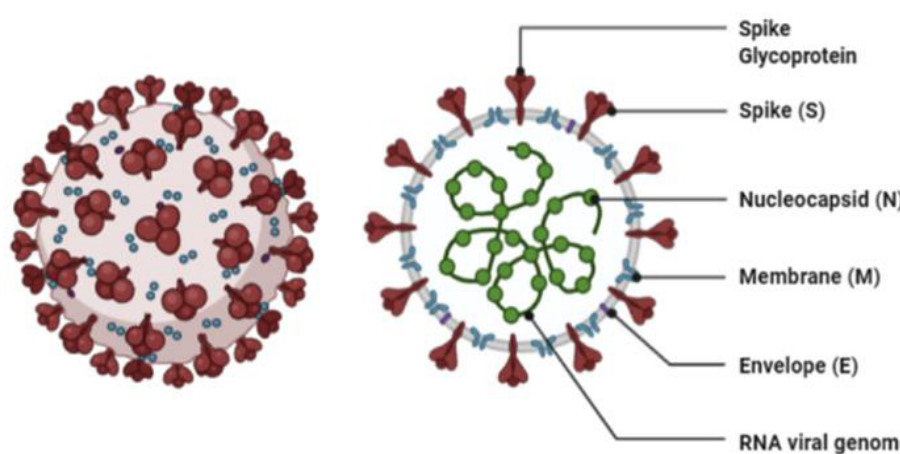
Figure 1. The structure of SAR-CoV-2 under a microscope as illustrated by Agarwal et al. [18]. SARS-CoV-2 binds to the host cell Angiotensin-Converting Enzyme 2 (ACE 2) through its spike proteins. These spike proteins consist of two subunits, the receptor-binding subunit, which facilitates binding of the virus to the host cell, and the membrane fusing subunit, which allows for the fusing of the membranes of the virus and host cell. Once the virus binds to the host cell, the viral molecule then enters into the host cell [19]. Prior to entering the cells, the protease enzyme TMPRSS2 activates the spike proteins. The combination of activation and binding to ACE2 are required for successful admission into the cell [20]. Once entered they translate small parts of the virus onto non-structural proteins. The proteins then form an enzyme called RNA Dependent RNA Polymerase. The enzyme induces a double membrane vesicle, through the restructuring of the endoplasmic reticulum of the cell. Once these vesicles are formed, continuous replication and transcrip- tion are made of the sRNA gene coding for SARS-CoV-2 [21]. Once this is complete all the viral proteins with the sRNA are collated in the endoplasmic reticulum and the Golgi apparatus of the cell, hence forming the new virus particle. These viruses then release and spread within the body, attacking target sites as mentioned above